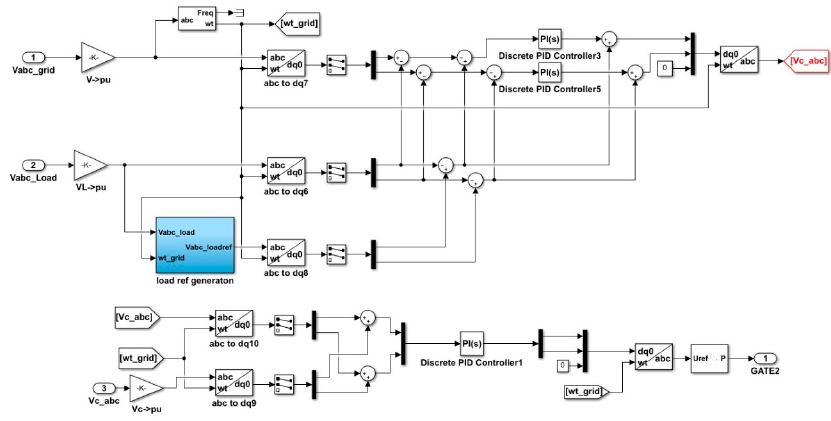
Figure 4. Series converter control system.